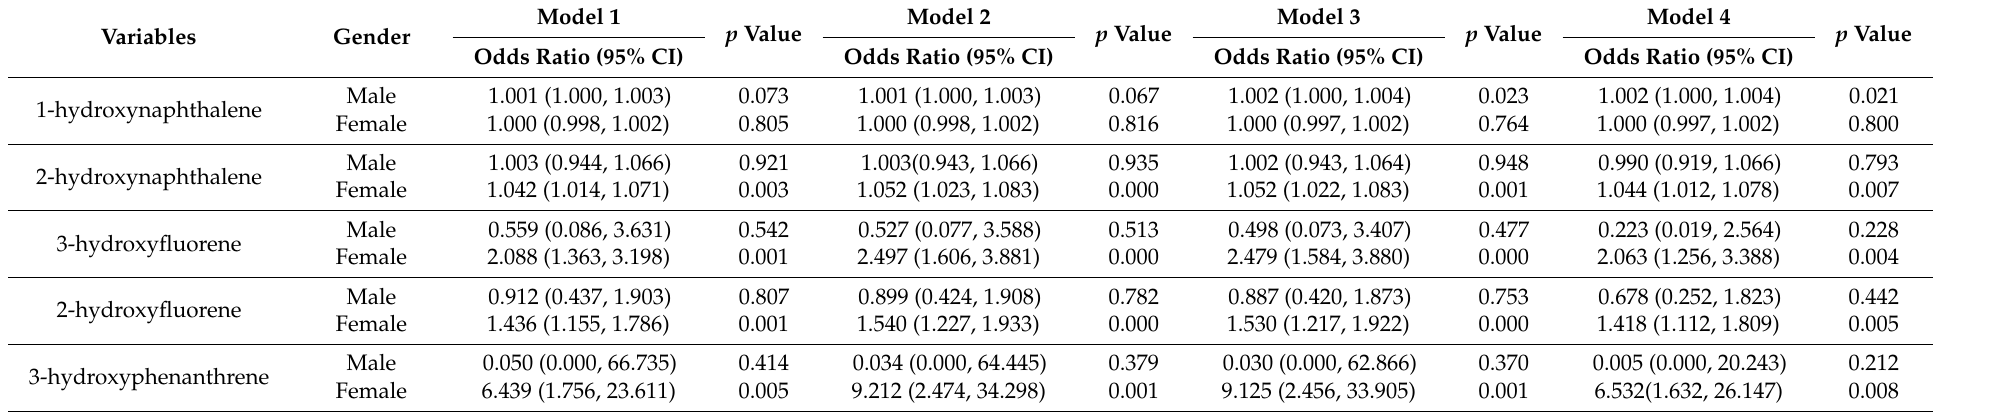
Table 4. Gender difference in association between PAHs and